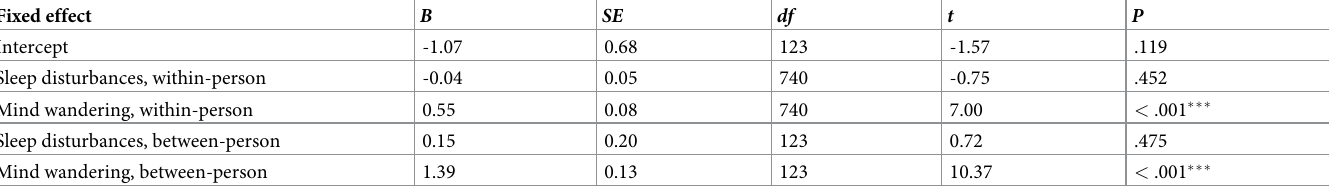
Table 3. Multilevel analyses with Mind wandering today and sleep last night as predictors of Maladaptive daydreaming today.